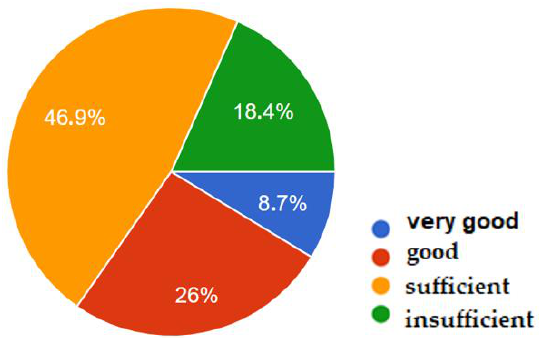
Figure 2. How do you assess your knowledge of renewable energy sources?